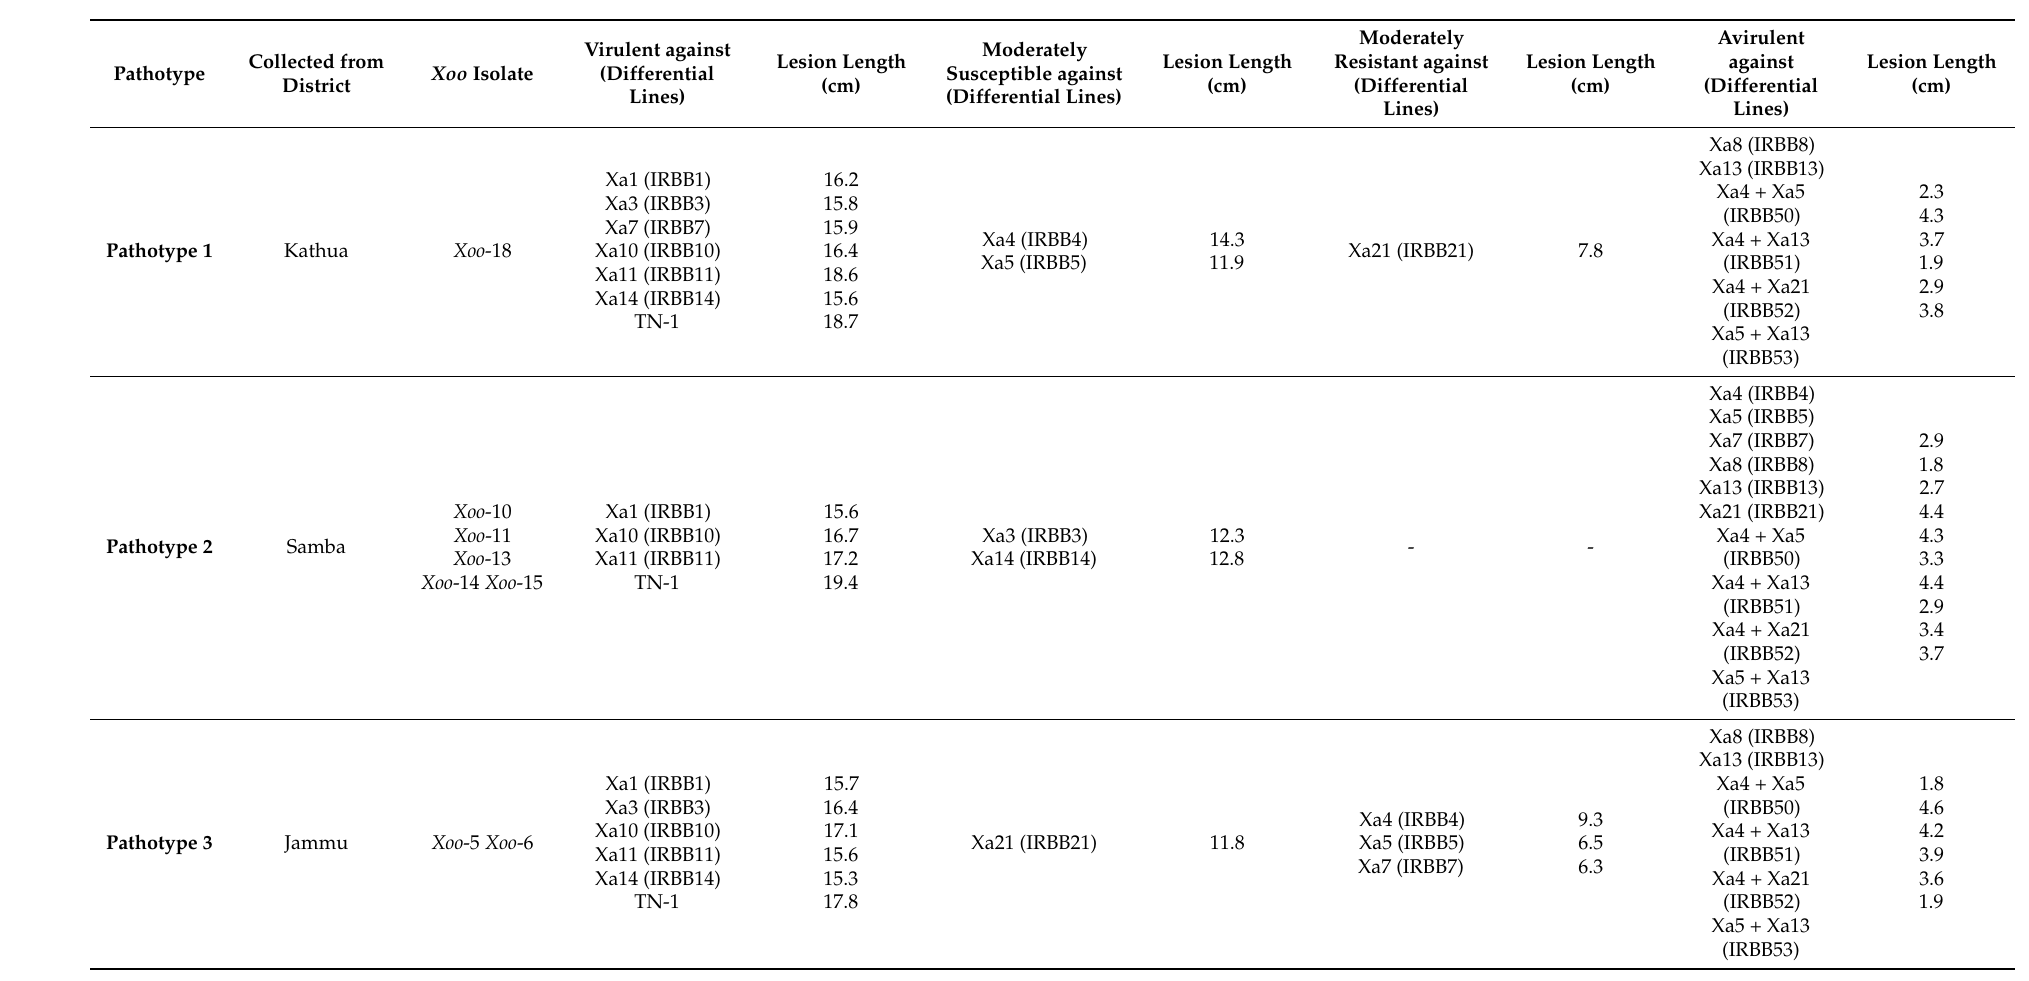
Table 6. Pathotypes of Xanthomonas oryzae pv. oryzae ( Xoo ) prevalent in Jammu, based on the disease reaction of Xoo isolates collected from various districts, on fifteen differential